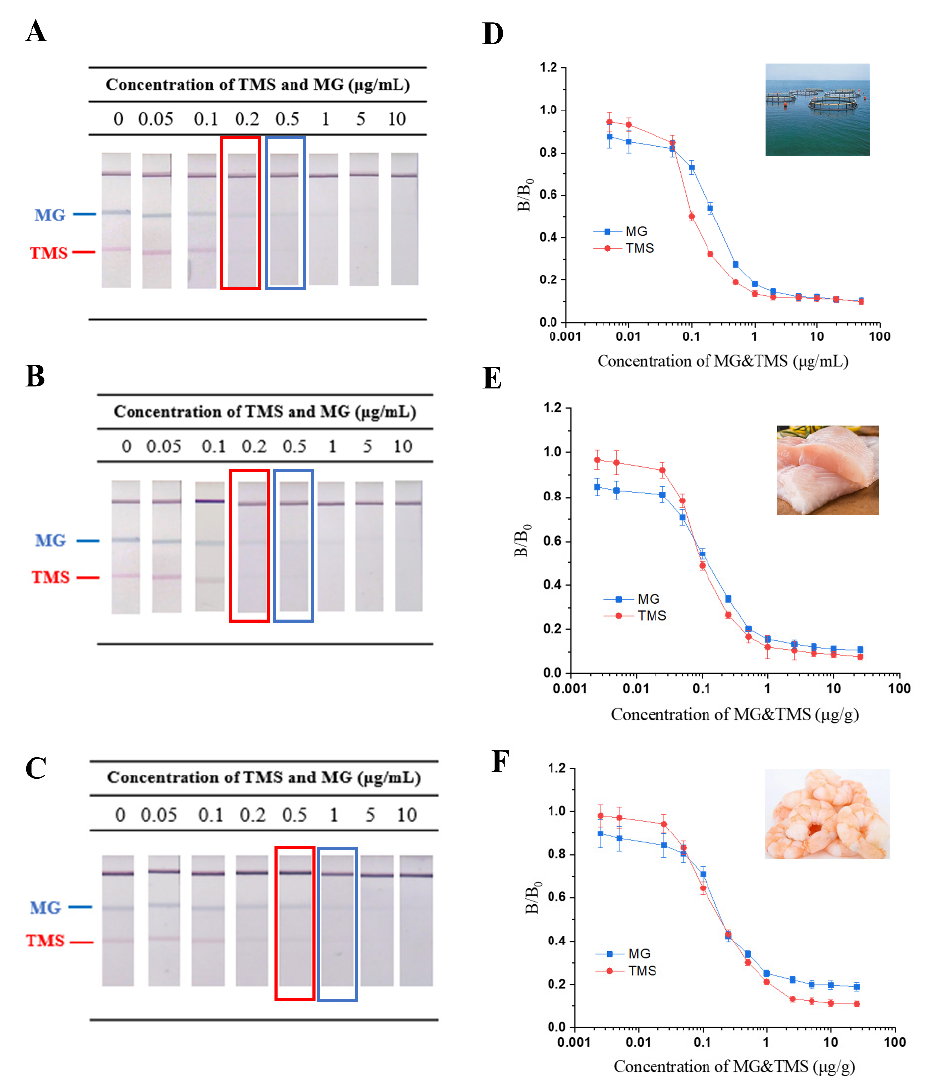
Figure 4. Simultaneous detection of TMS and MG in spiked samples with TS-DTL. Qualitative detection for aquaculture water ( A ), fish ( B ) and shrimp ( C ). Calibration curves of TMS and MG in aquaculture water ( D ), fish ( E ) and shrimp ( F ).